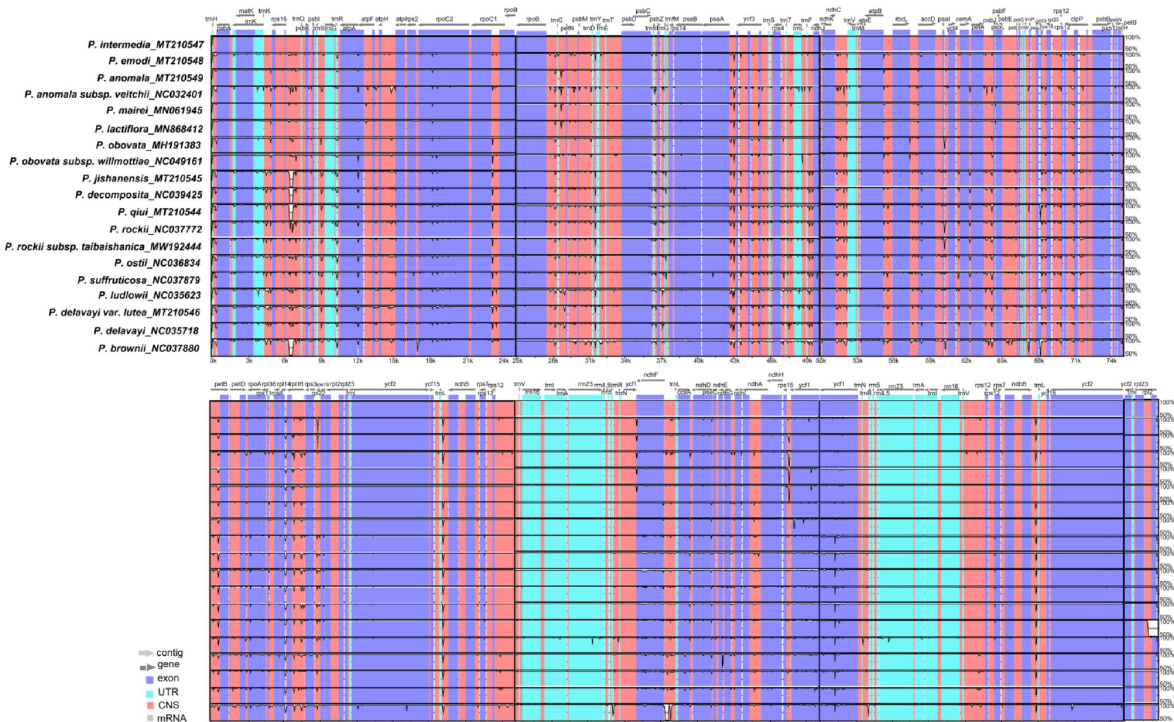
Figure 5. Global alignment of chloroplast genomes of 19 Paeoniaceae species. The x-axis represents the coordinates in the chloroplast genome. The y-axis indicates the average percent identity of sequence similarity in the aligned regions, ranging between 50 and 100%. Genome regions are color coded as protein coding, rRNA coding, tRNA coding, or conserved noncoding sequences